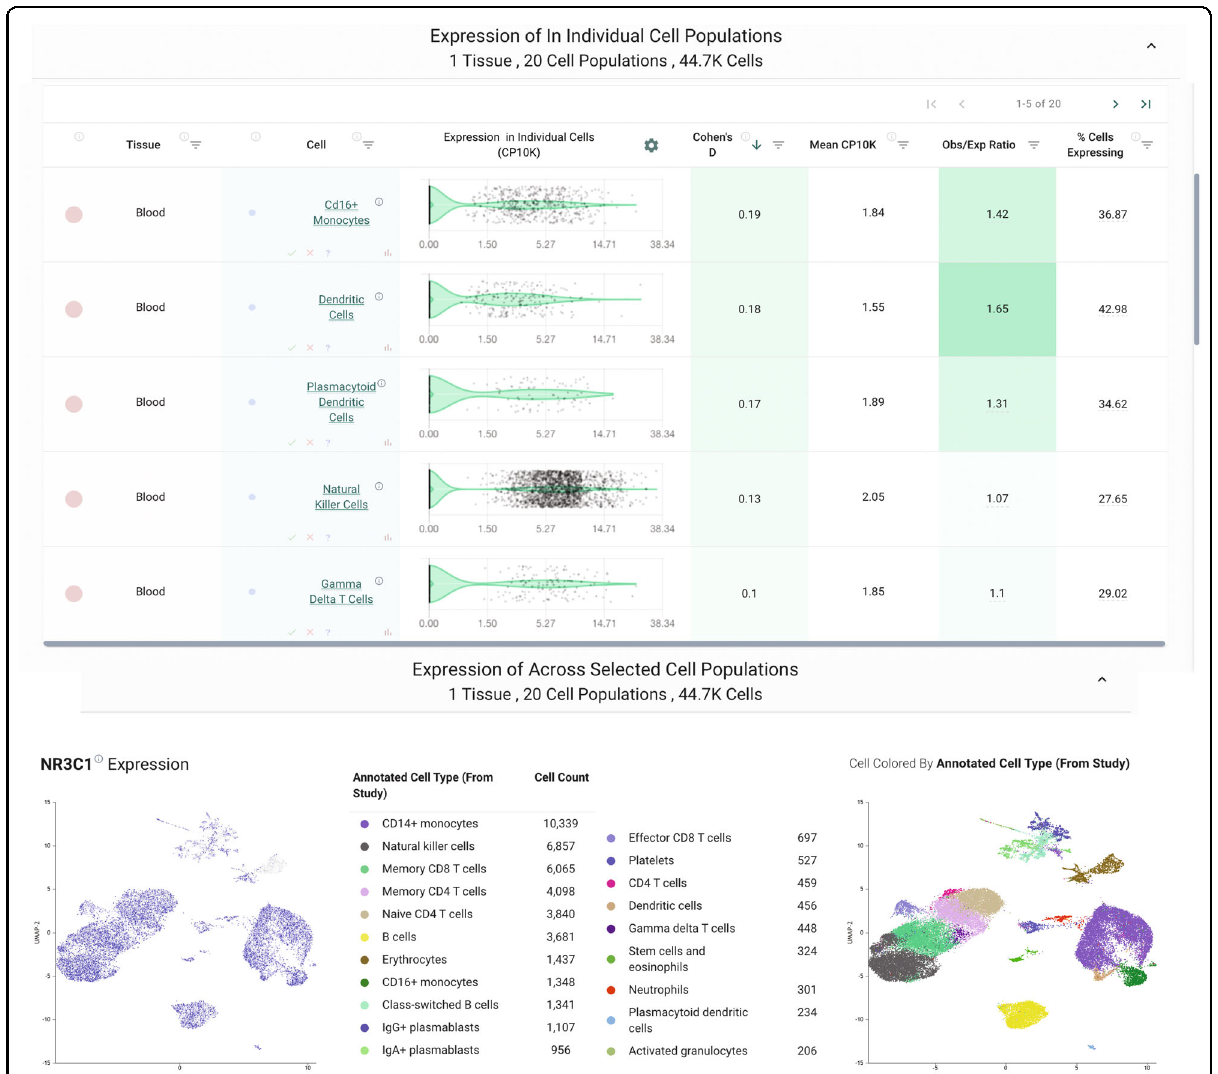
Fig. 4 nferX single-cell platform analysis of NR3C1 expression. In a study of peripheral blood samples from healthy donors ( n = 6) and COVID-19 patients between days 2 and 16 of symptom onset ( n = 7), NR3C1 was appreciably expressed in diverse immune cell types including T cells, B cells, dendritic cells, monocytes, and plasmacytoid dendritic